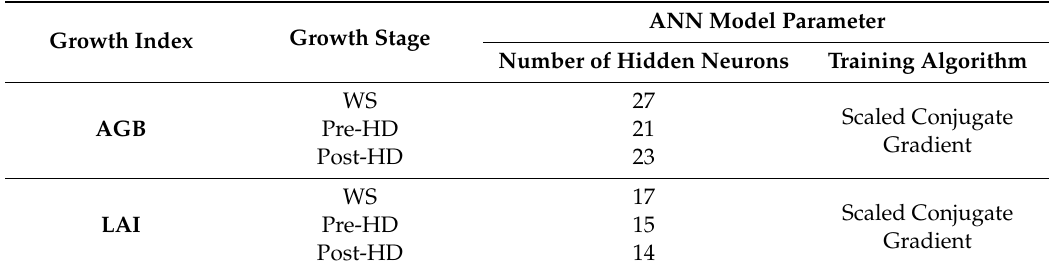
Pre-HD Post-HD WS Scaled Conjugate Table 5. Parameters for artificial neural networks (ANN) and random forests (RF) regression models. LAI Pre-HD 15 Gradient Post-HD 14 ANN Model Parameter Note: WS represents the whole season, Pre-HD represents pre-heading stages and Post-HD represents Growth Index Growth Stage Number of Hidden Neurons Training Algorithm post-heading stages. WS 27 Scaled Conjugate AGB Pre-HD 21 Gradient Post-HD 23 WS 17 Scaled Conjugate LAI Pre-HD 15 Gradient Post-HD 14